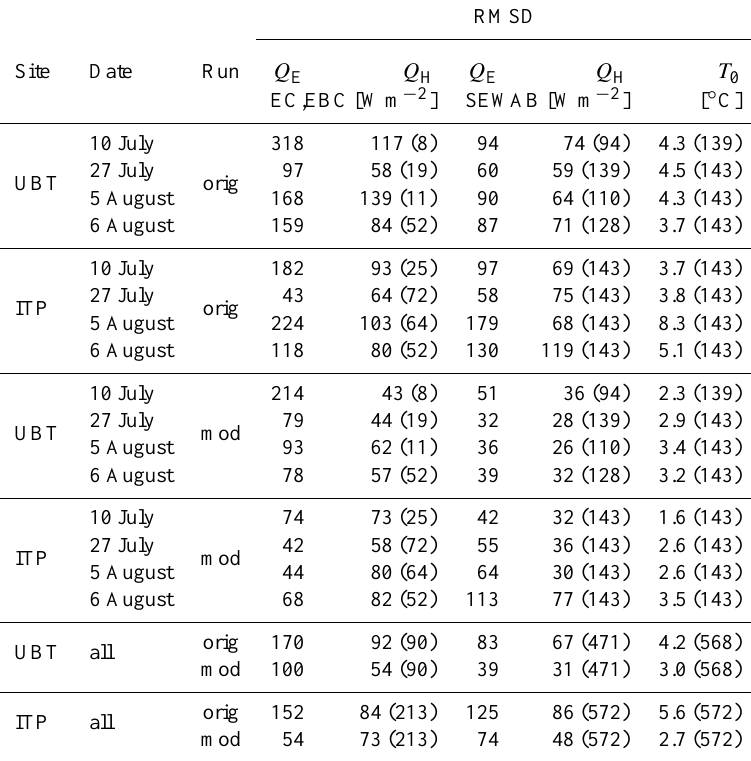
Table 3. Root mean square deviation (RMSD) between the modelled quantities of the original and modified Hybrid and reference values. The reference quantities used are either measured by EC and corrected for energy balance closure (EC,EBC) or modelled with SEWAB for fluxes or taken from longwave outgoing radiation for T 0 . The values in parenthesis ( N ) correspond to the number of elements used for calculation of RMSD and R 2 (l = 0 ) in Fig.